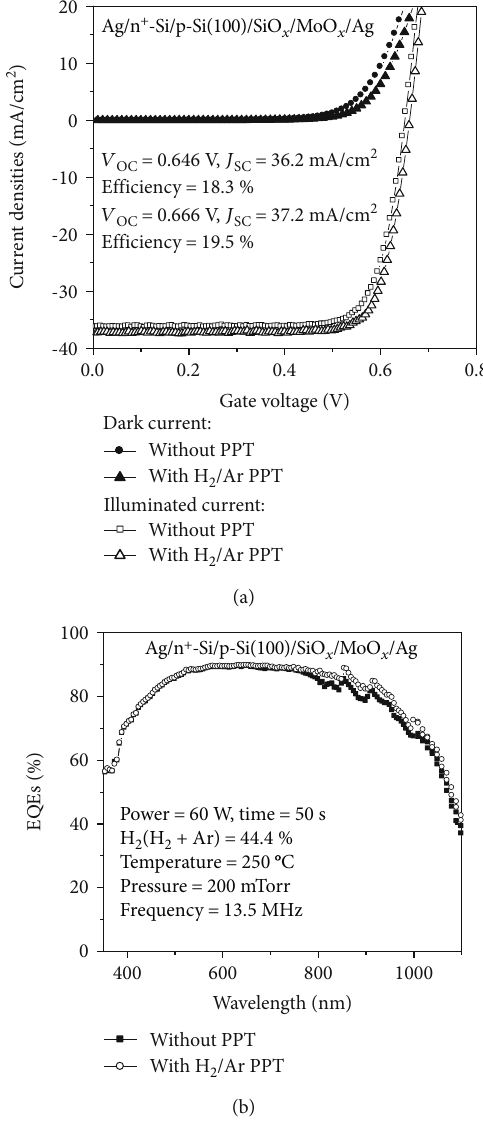
Figure 7: (a) Dark and illuminated (AM 1.5G) current density vs. voltage curves of the SPSSCs with and without H EQEs of the SPSSCs with and without H